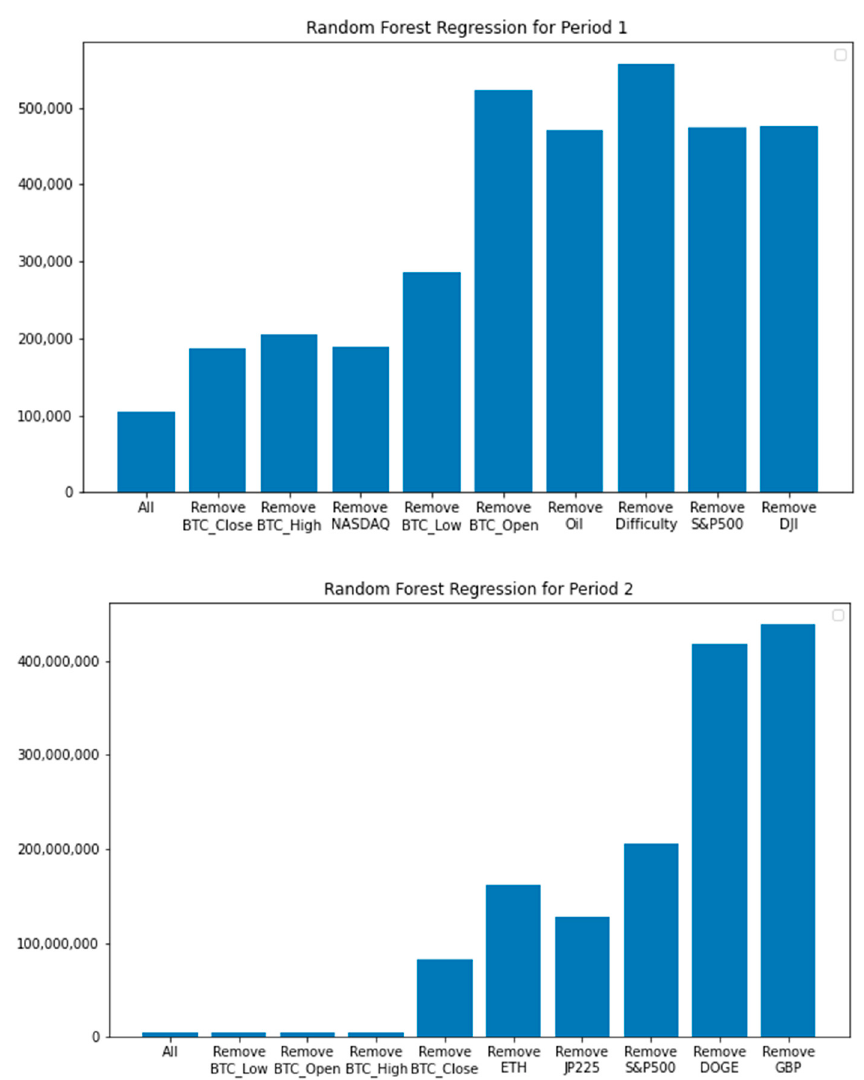
Figure 10. RMSE after removing the most important